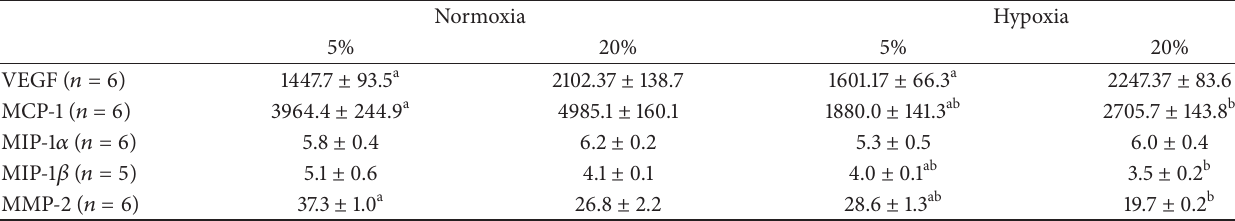
Table 2: Paracrine factors in media.